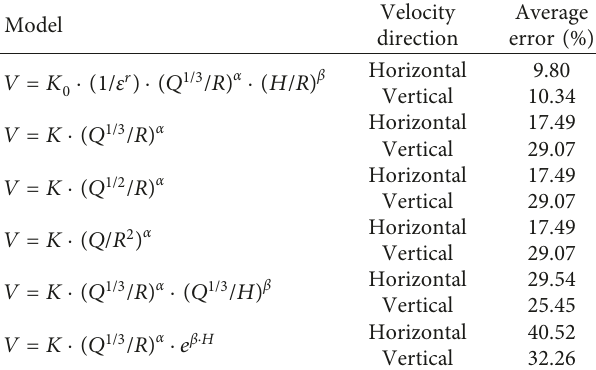
Table 9: Comparison of the performance of new formula with the other related studies.